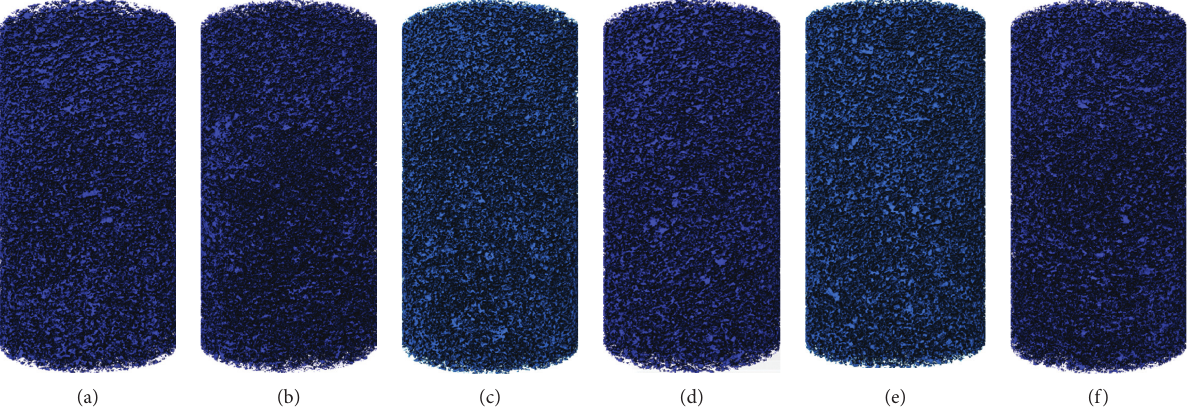
Figure 5: Rendering of all pore structures in the samples.